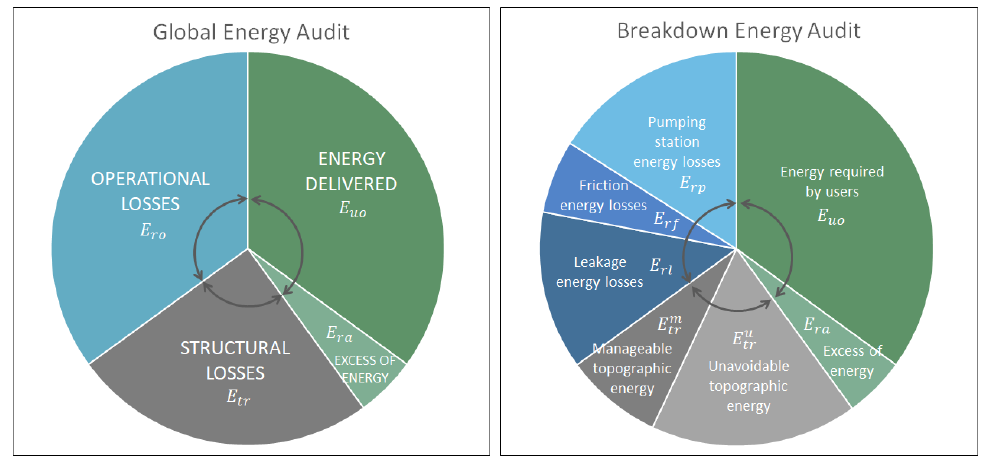
Figure 4. Energy audit of a Pressurized Water Transport System (PWTS).